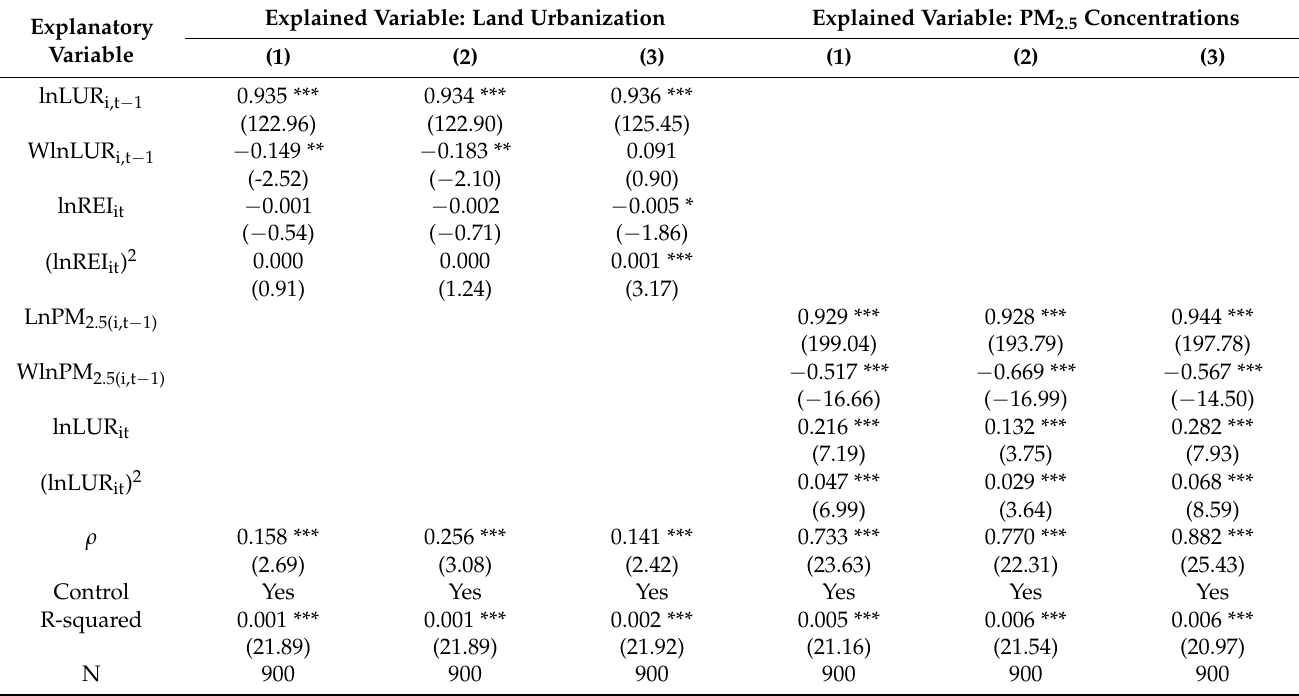
Table 8. Estimation results of the conduction